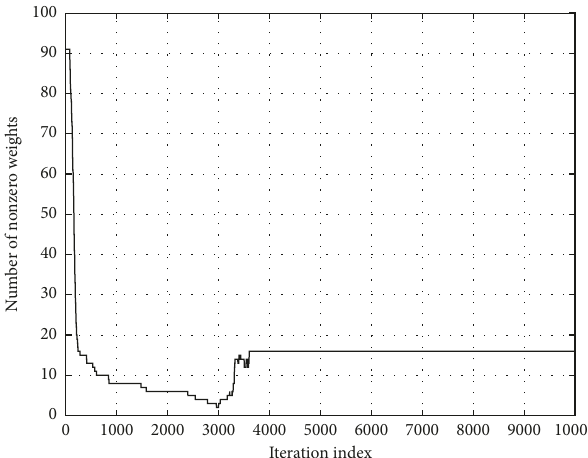
Figure 4: Number of nonzero weights vs. iteration number.